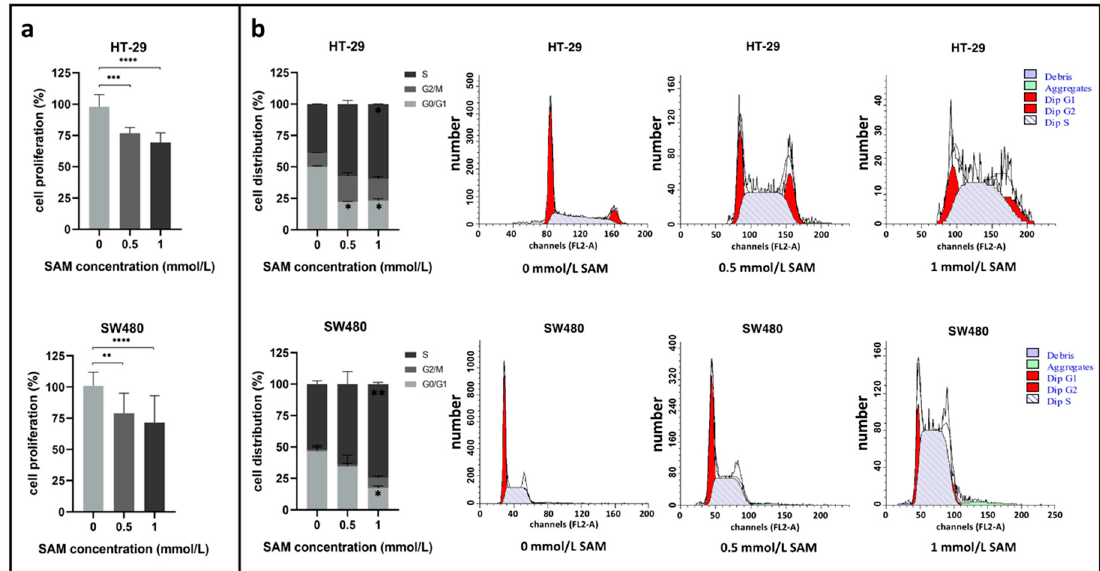
Figure 1. ( a ) Cell proliferation of HT-29 and SW480 cells were analyzed with SRB (sulforhodamine B) assay. The median of control (0 mmol/L S-adenosylmethionine (SAM)) cells was taken as 100% and the average results of the treatment groups (0.5 mmol/L; 1 mmol/L SAM) were compared to this value (** p ≤ 0.005, *** p ≤ 0.0005, and **** p ≤ 0.0001). ( b ) Cell cycle alterations were detected with FACS (fluorescence-activated cell sorting) in HT-29 and SW480 cells. Left: Percentage of cell distribution in different phases of the cell cycle (* p ≤ 0.05, ** p ≤ 0.005). Right: Representative histograms about each treatment conditions. Dip: diploid.